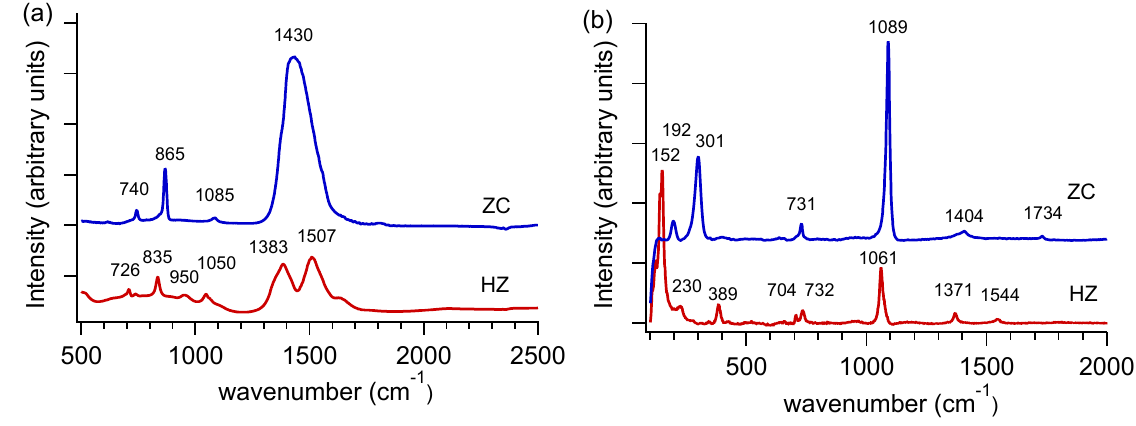
Figure 3. Representative ( a ) Fourier transform infrared spectroscopy (FTIR) spectra and ( b ) Raman spectra for ZnCO along the vertical axis for